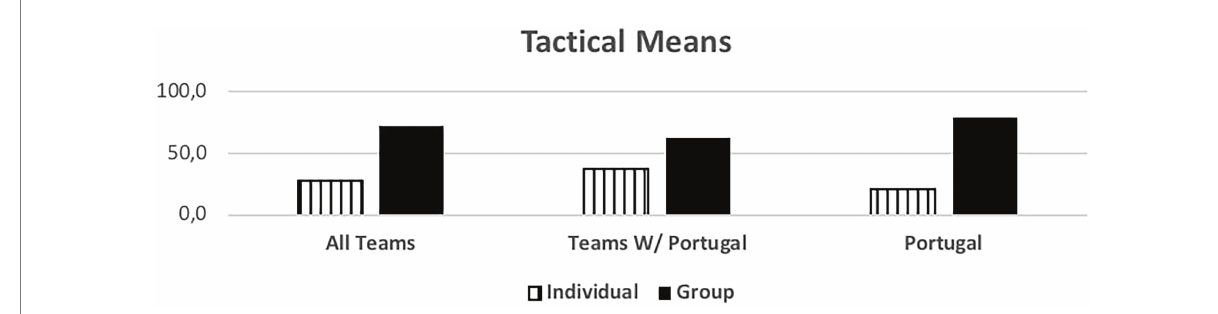
FIGURE 3 Tactical means. Individual tactical means – Shot, feint; Group tactical means – cross, position change, block, screen.